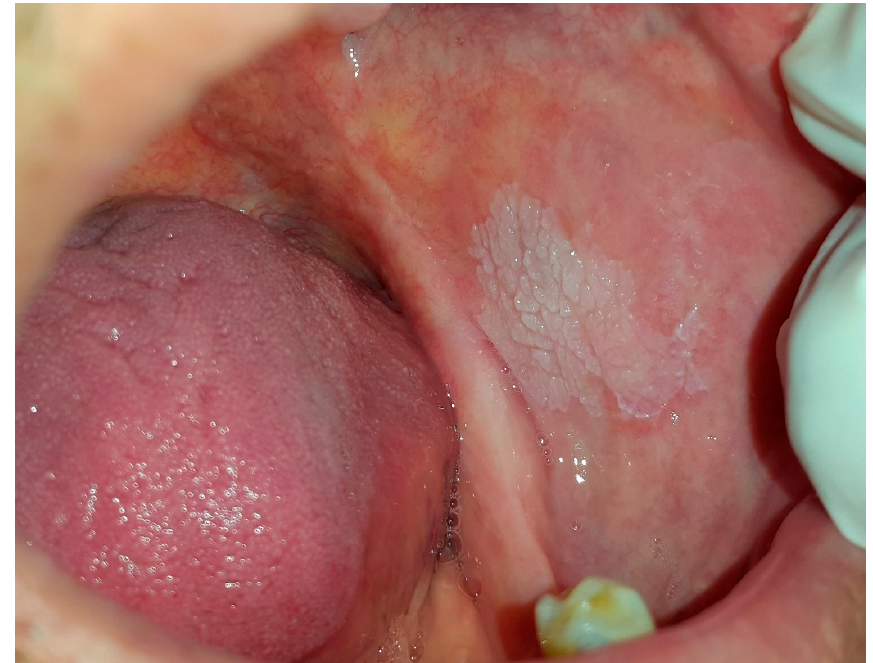
Figure 8. Leukoplakia on the buccal mucosa.